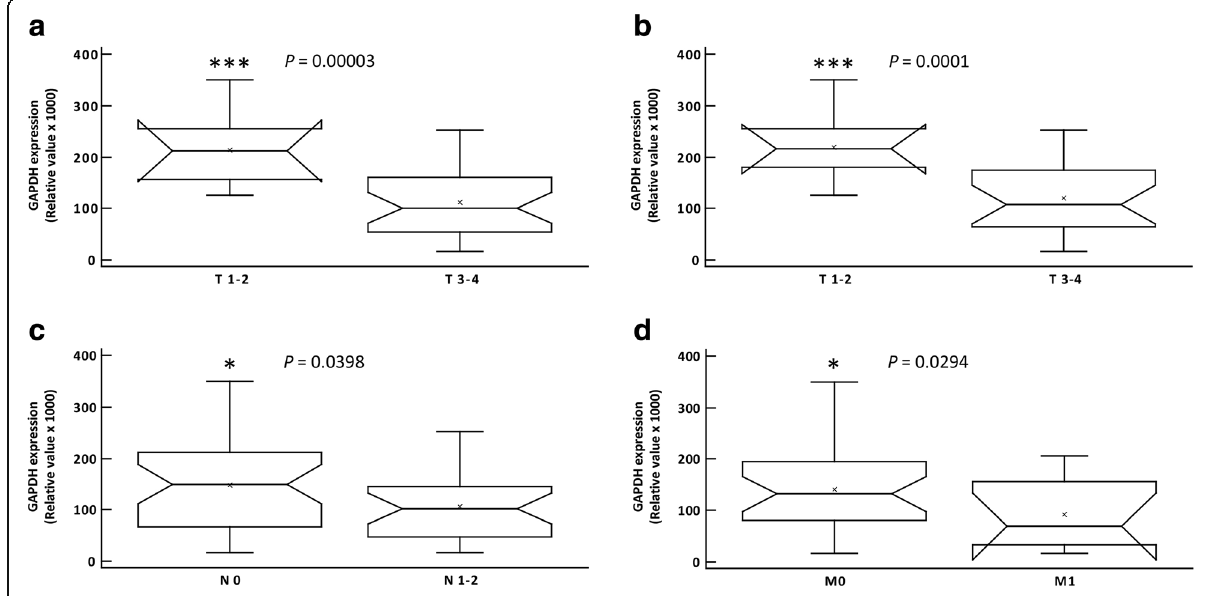
Fig. 3 Correlation between GAPDH expression and TNM classifications. a GAPDH expression in relation to the primary tumour extent in all 62 patients and ( b ) in patients who had not developed distant metastasis. In both cases, GAPDH expression is significantly higher in tumours that have only affected the most external layers of the colonic wall (submucosa and muscularis propria) than in tumours in more invasive stages (invasion into the subserosa, non-peritonealised pericolic or perirectal tissues, other organs and/or perforation of visceral peritoneum). c The presence of metastases in regional lymph nodes is correlated with a significant decrease in primary tumour GAPDH expression. d In the absence of distant metastasis, tumours express significantly higher levels of GAPDH